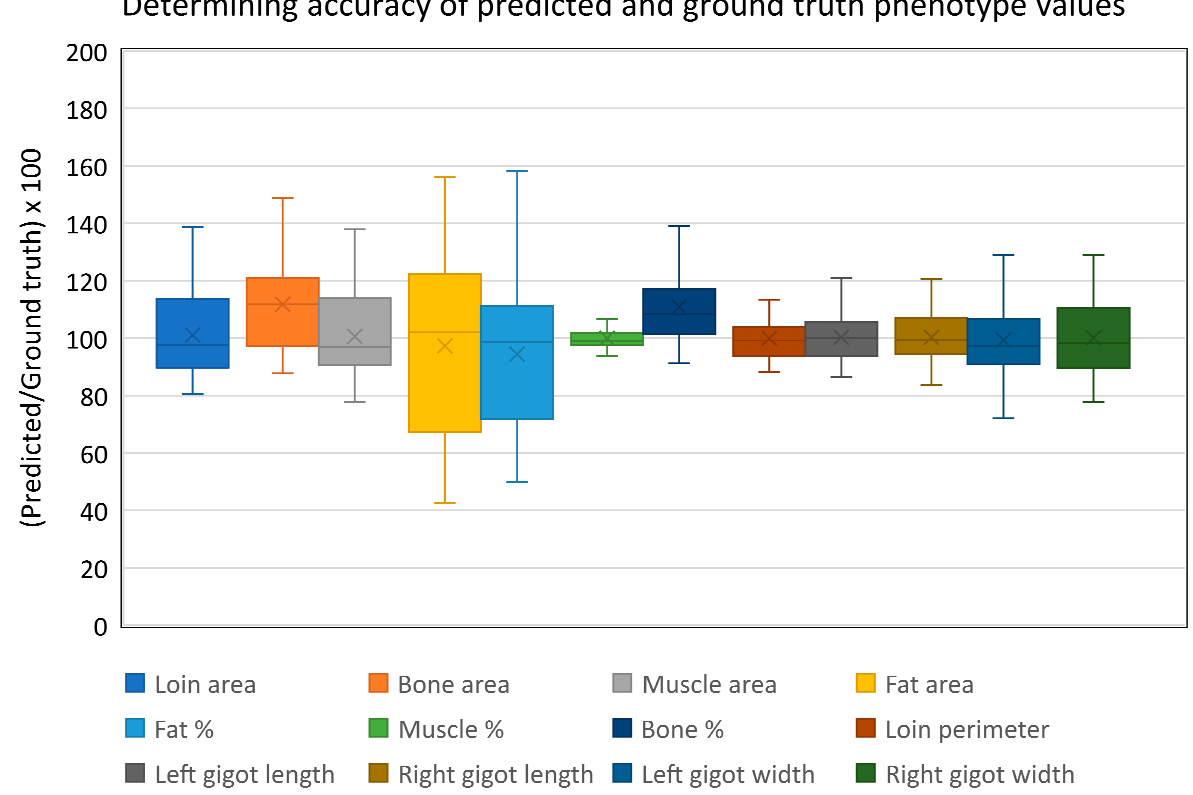
Figure 8. Comparing values of predicted and ground truth phenotypes. Prediction estimation accuracy was determined by comparing phenotype values generated from both predicted and ground truth datasets using the computer vision pipeline. Across all phenotypes, predicted values for each image were on average 101.44% that of the ground truth value with a standard deviation of 12.90% (n = 32).